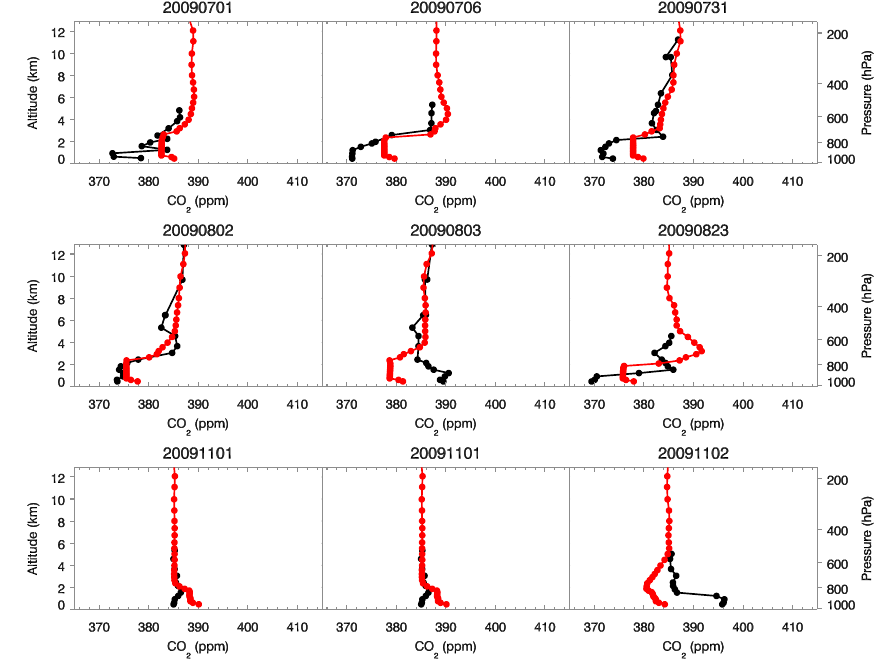
Fig. 5. Samples of CO 2 profiles measured by aircraft (black) and TES/GEOS-Chem assimilation (red) at SGP.